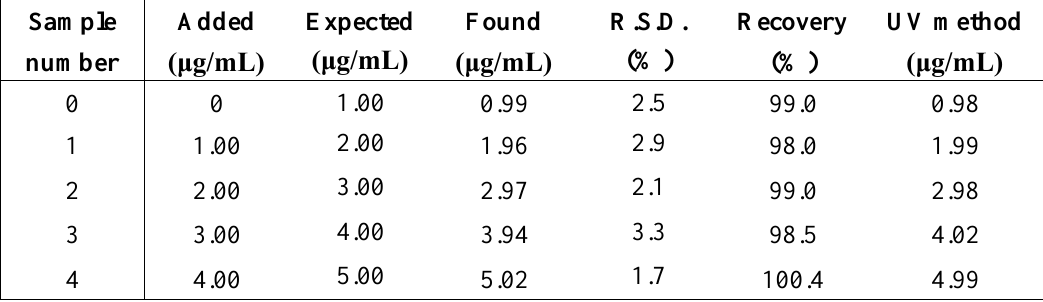
Table 1. Measurement results of doxepin in drug tablets (n =